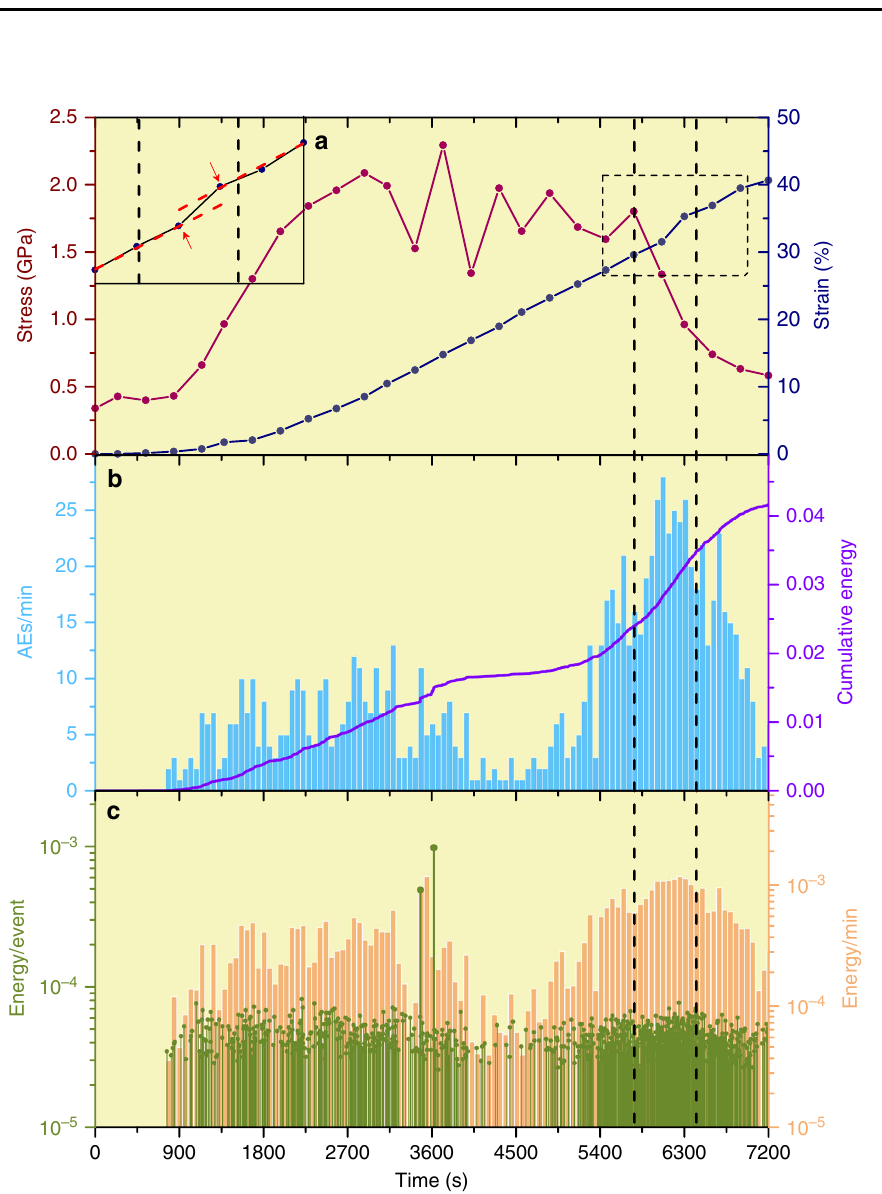
Fig. 2 History of mechanical behavior and AE activity of a G sample (D1996) during deformation. a Differential stress and strain. Note large fl uctuation in stress between 2700 and 5400 s. At macroscopic failure (centered around 6000 s, between two vertical dashed lines), a sudden jump in strain is observed (dashed box), associated with a > 50% stress drop. Inset is enlarged portion of the dashed box, showing the strain jump. b AE rates (in # per min) and cumulative energy release (in arbitrary units) during deformation. Note the two broad burst episodes and the peak centered around 6000 s, which corresponds to the strain jump and stress drop in a . c Individual relative AE energy (in arbitrary units) and energy release rate. Only two events near 3600 s are signi fi cantly large than the rest. The rest of the AE events have similar magnitudes, corresponding to M W around − 8.4 – 8.8 45 . Energy release rate also peaked around 6000 s. Vertical dashed lines mark the time window in which the AE activity peak ( b , c ) coincides with the strain jump during the stress drop ( a )